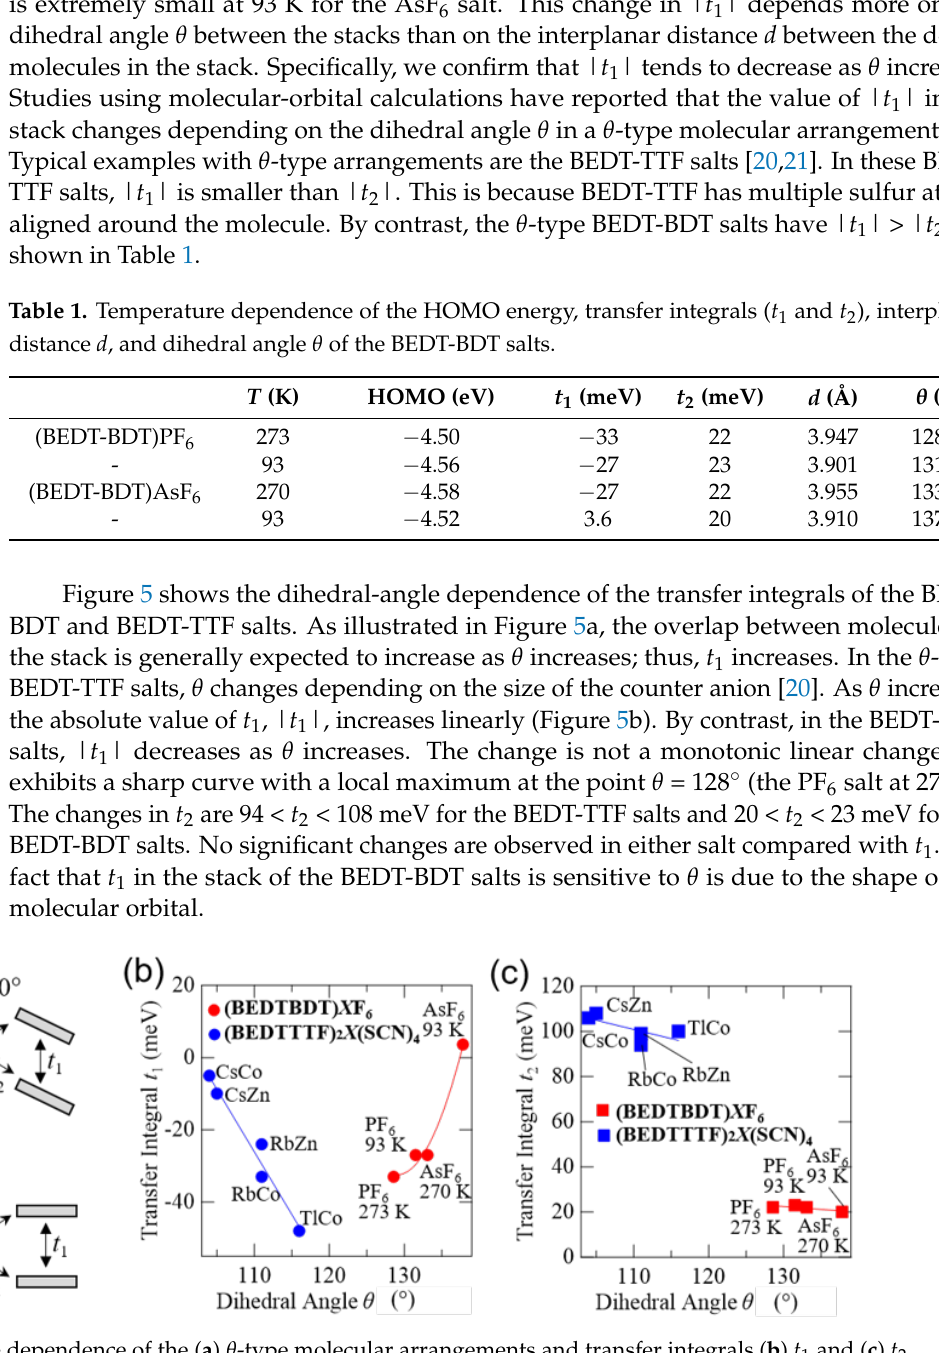
Figure 5. Dihedral-angle dependence of the ( a ) θ -type molecular arrangements and transfer integrals ( b ) t 1 and ( c ) t 2 .